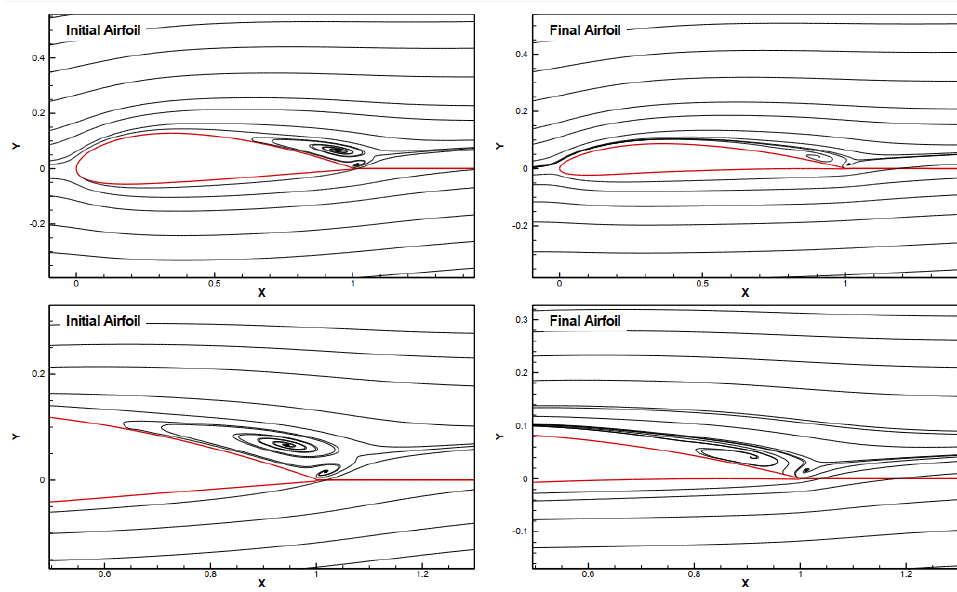
Figure 10. The streamlines around the airfoil were observed in both the initial and final conditions of the multipurpose